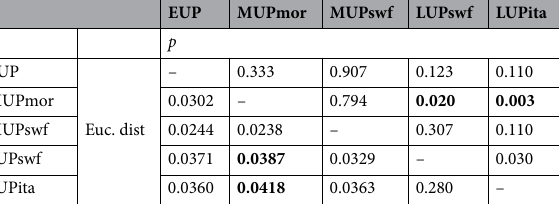
Table 5. Euclidean distances between the group averages calculated from the 15 first PCs. P-values of pairwise group differences based on permutation